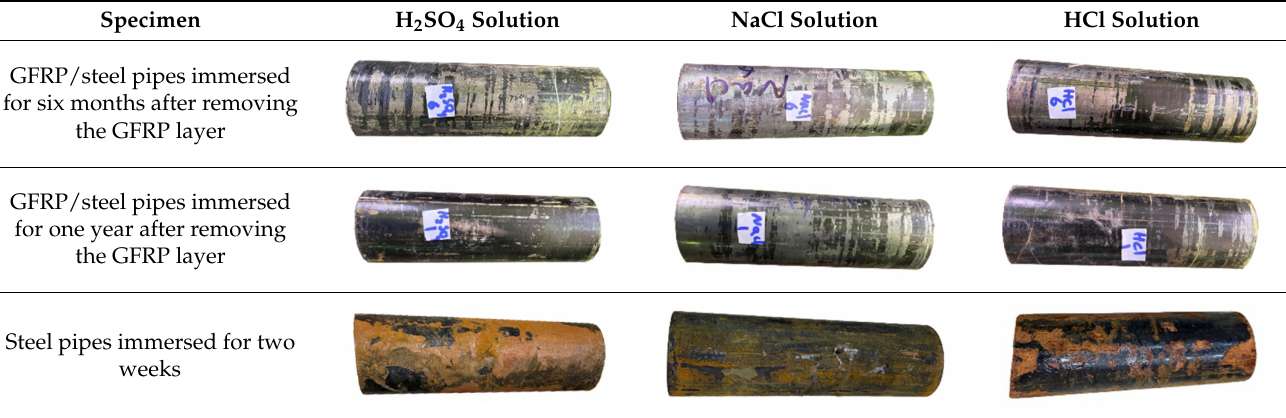
Figure 3. Gamma-ray radiography for the GFRP/steel pipe immersed in HCl solution for 1 year. After taking all the immersed pipe out of the solution, the Teflon cups were removed, and the FRP layer was cut and peeled off from the steel pipes. The corrosion condition was observed and qualitatively analyzed by visual inspection, scanning electron microscopy (SEM), X-ray diffraction analysis (XRD), and energy-dispersive X-ray spectroscopy (EDX). Photos for the immersed pipes after the end of the immersing test are presented in Table 5. By visual inspection, no areas of pitting corrosion were noticed in all the overwrapped steel pipes. Table 5. Photos for the immersed pipes after the end of the immersing